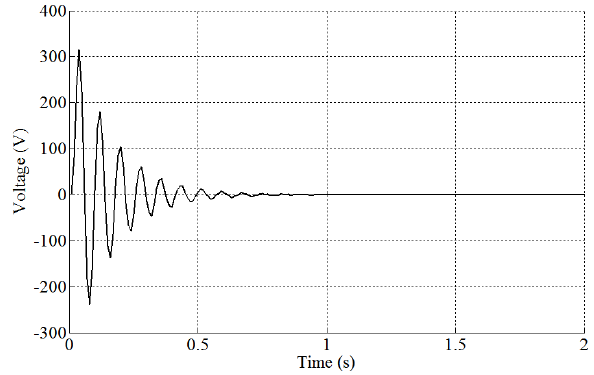
Figure 6: Control voltage variation under transient excitation